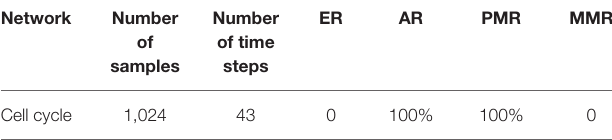
TABLE 2 | Experimental results for reconstructed time series